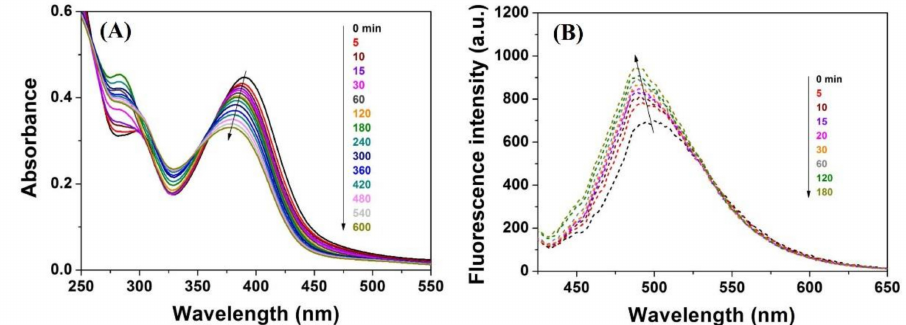
Figure 4. ( A ) UV-vis and ( B ) emission spectra of CMCS-DEACMS-2 micelles upon irradiation under simulated sunlight with di ff erent irradiation